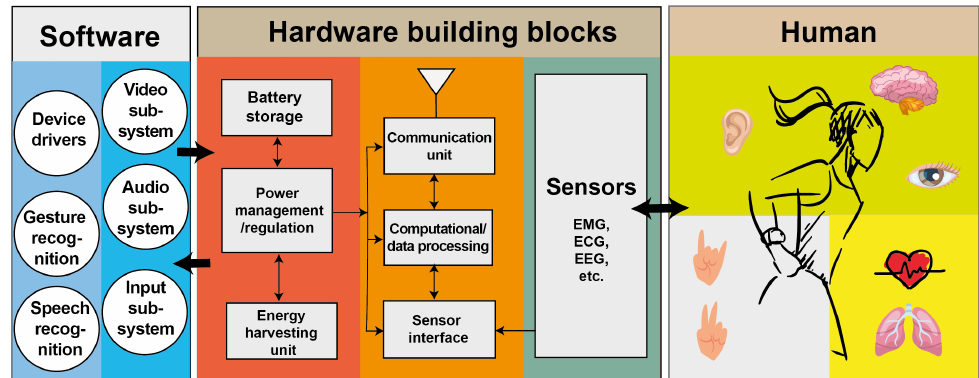
Figure 3. Concept diagram showing the software and hardware building blocks of wearable devices for educational purposes. The main hardware building blocks of a wearable device are the sensors, readout circuit interface, the energy harvester as well as the power management and telecommunica- tions units. The software component can be programmed to drive the wearable’s hardware according to different subsystems and inputs from sensors, e.g., video, audio, gesture and